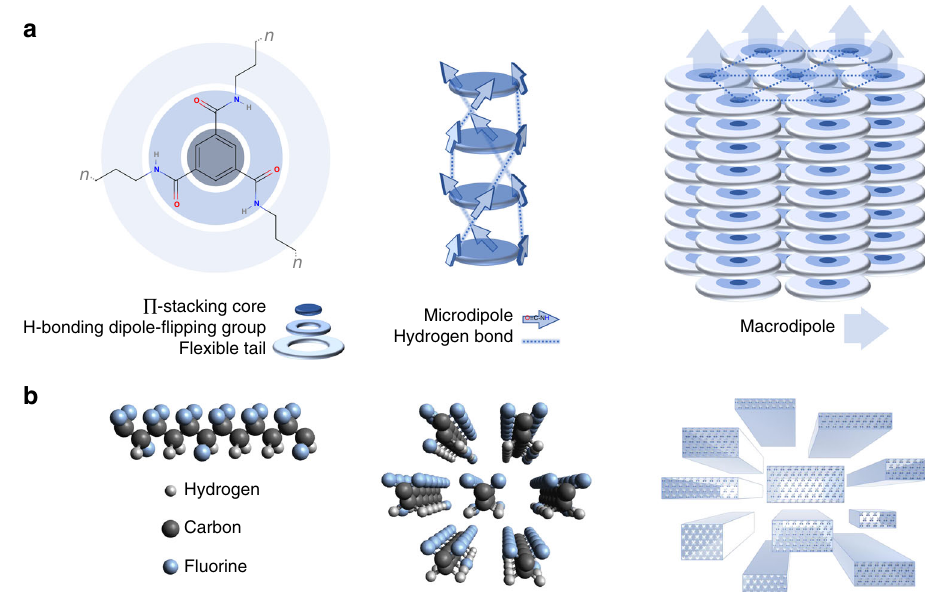
Fig. 2 Primary, secondary, and tertiary structure of the examined materials. a BTA and b P(VDF-TrFE) 58 . Discotic BTA molecules stack in a head-to-tail manner forming helical hydrogen-bonded microdipole system. Molecular stacks further self-assemble into a columnar hexagonal lattice. P(VDF-TrFE) copolymer chains, consisting of all-trans conformation − CH 2 − CF 2 − and − CHF − CF 2 − segments, pack pseudo-hexagonally within crystallites. Semi- crystalline nature of the material results in these crystallites being surrounded by an amorphous